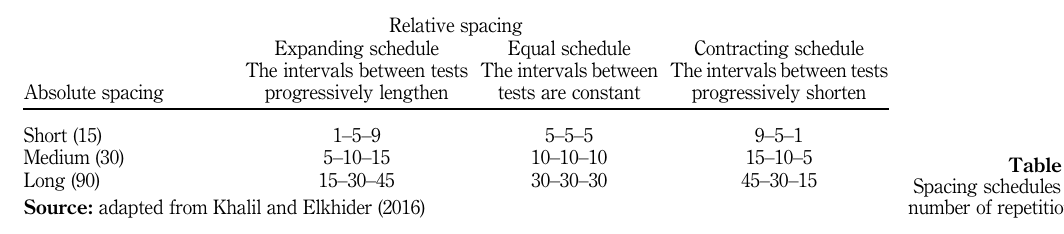
Table II. Spacing schedules